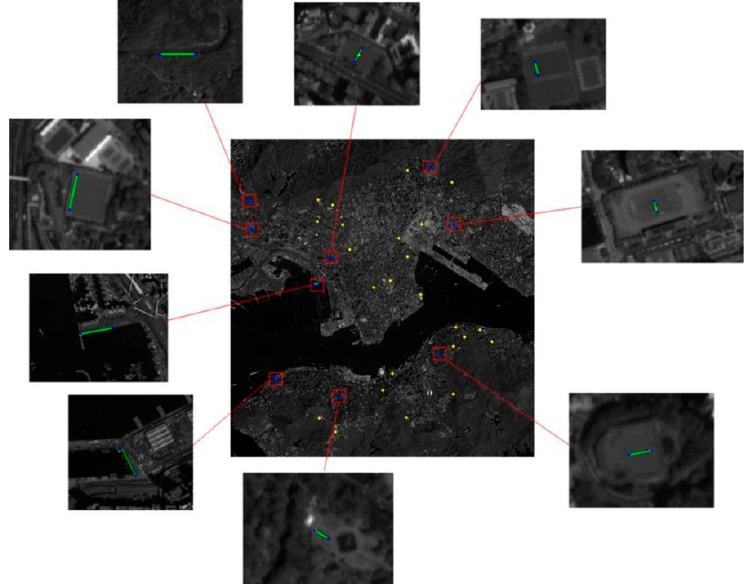
Figure 5. Distribution of real control lines in the Hong Kong area.